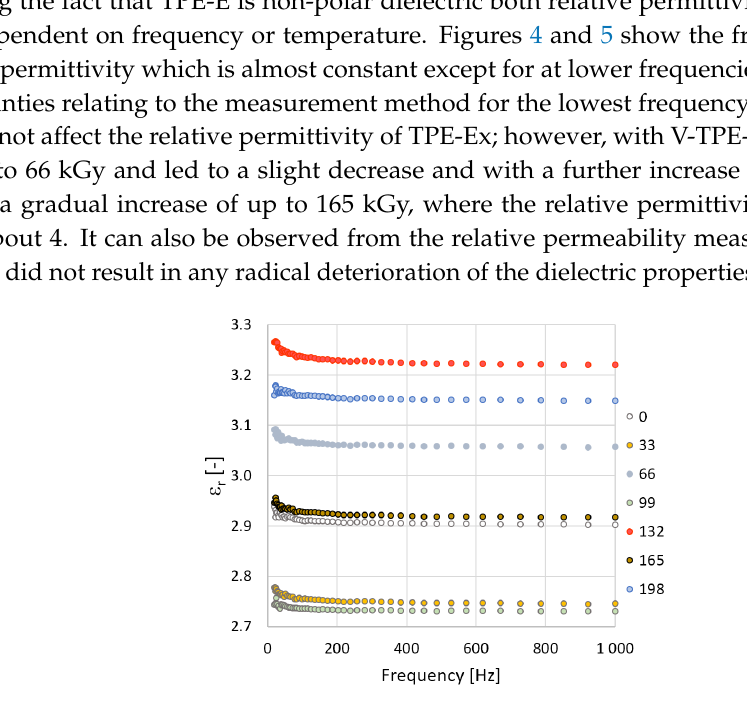
Figure 4. TPE-E—measurement course of the relative permittivity in dependence on frequency.